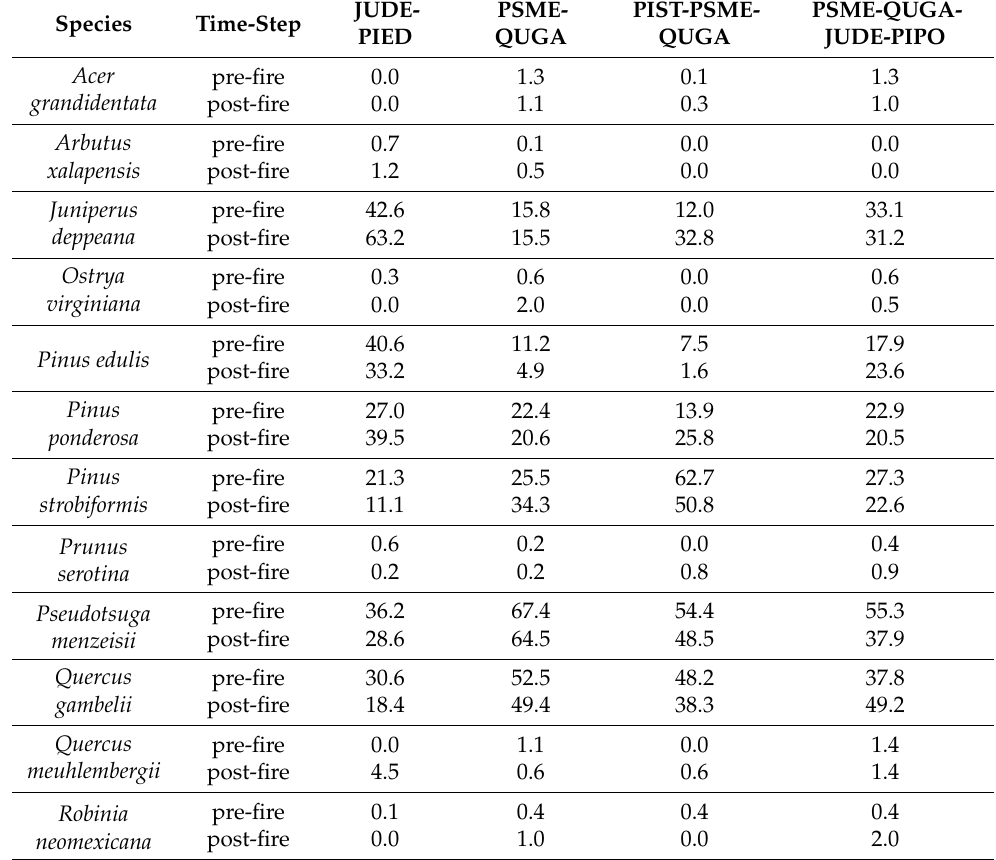
Table 2. Mean species importance values for each time-step in each of the four dominant vegetation types in Guadalupe Mountains National Park. Importance values were calculated as the sum of the relative tree basal area and density for all stems in each plot. JUDE-PIED indicates the alligator juniper- piñon pine vegetation type, PSME-QUGA stands for the Douglas fir-Gambel oak vegetation type, PIST-PSME-QUGA is the southwestern white pine-Douglas fir-Gambel oak type, and PSME-QUGA- JUDE-PIPO indicates the Douglas fir-Gambel oak-alligator juniper-ponderosa pine vegetation